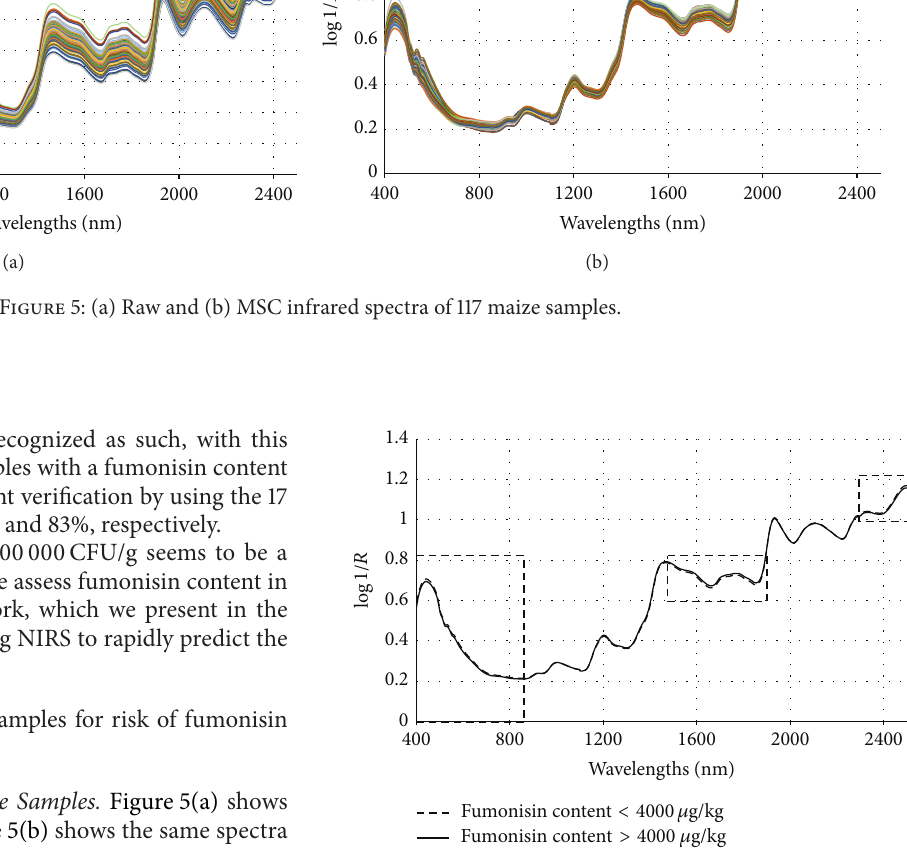
Figure 6: NIR reflectance spectra for maize sample with fumonisin content above (solid line) and below (dashed line) the EU